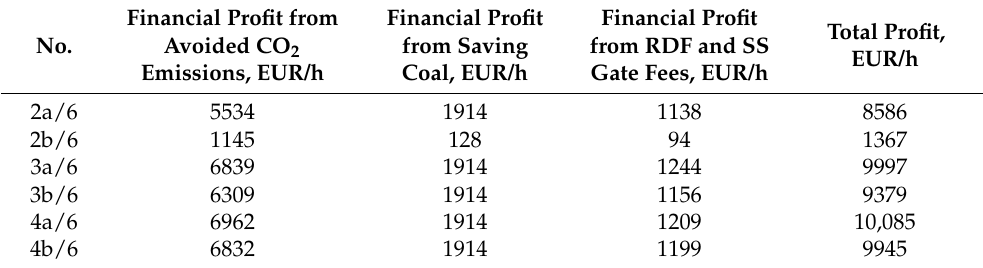
Table 11. The economic